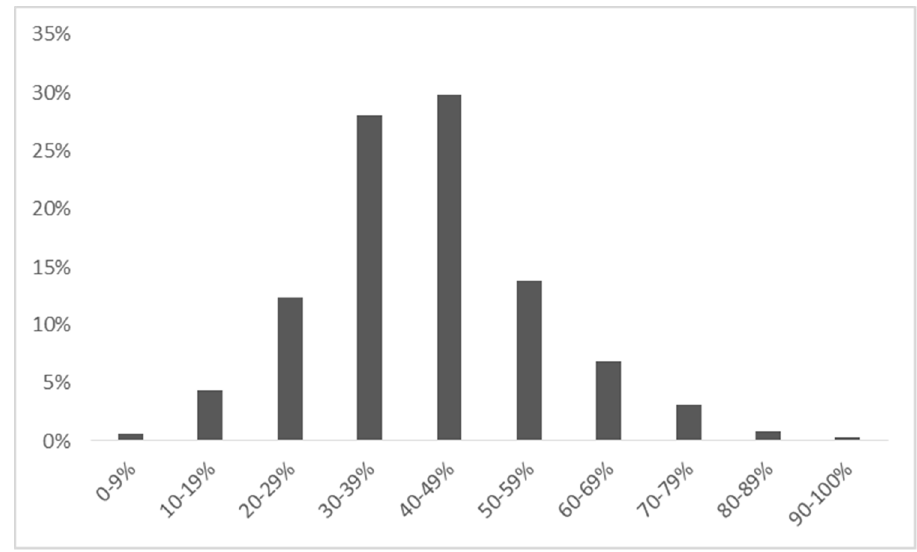
Figure 1. Attainment levels of Scottish schools (percentage of pupils with 3+ level 6 awards in 2014/15). Table 2. Attainment level of schools of pupil interviewees (percentage of pupils attaining 3+ level 6 awards in